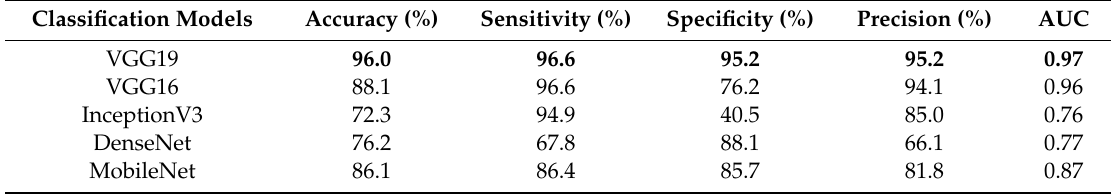
Table 5. Performance evaluation of the five deep neural network (DNN)